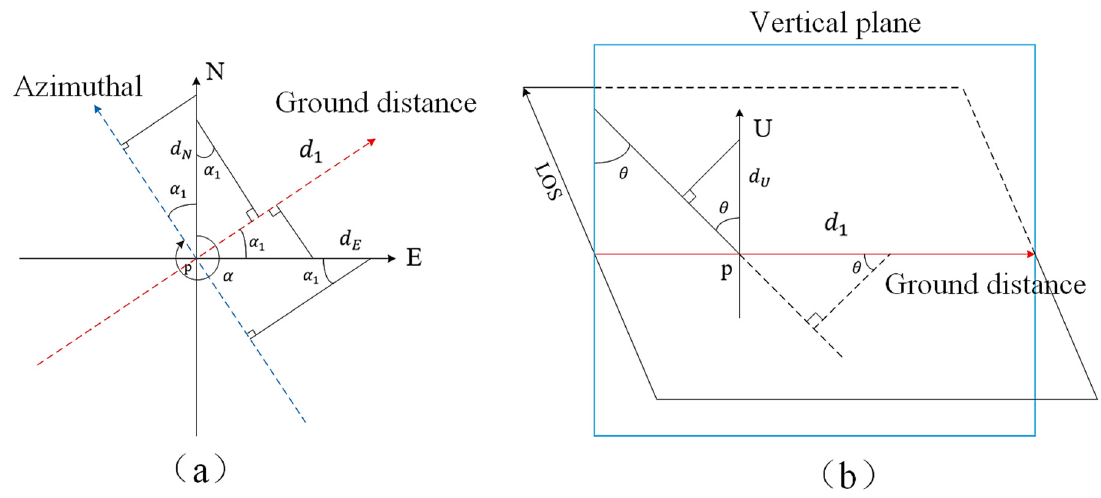
Figure 16. Deformation projection geometry. ( a ) shows the azimuthal and geodetic projection of the satellite, ( b ) shows the line-of-sight projection of the satellite.